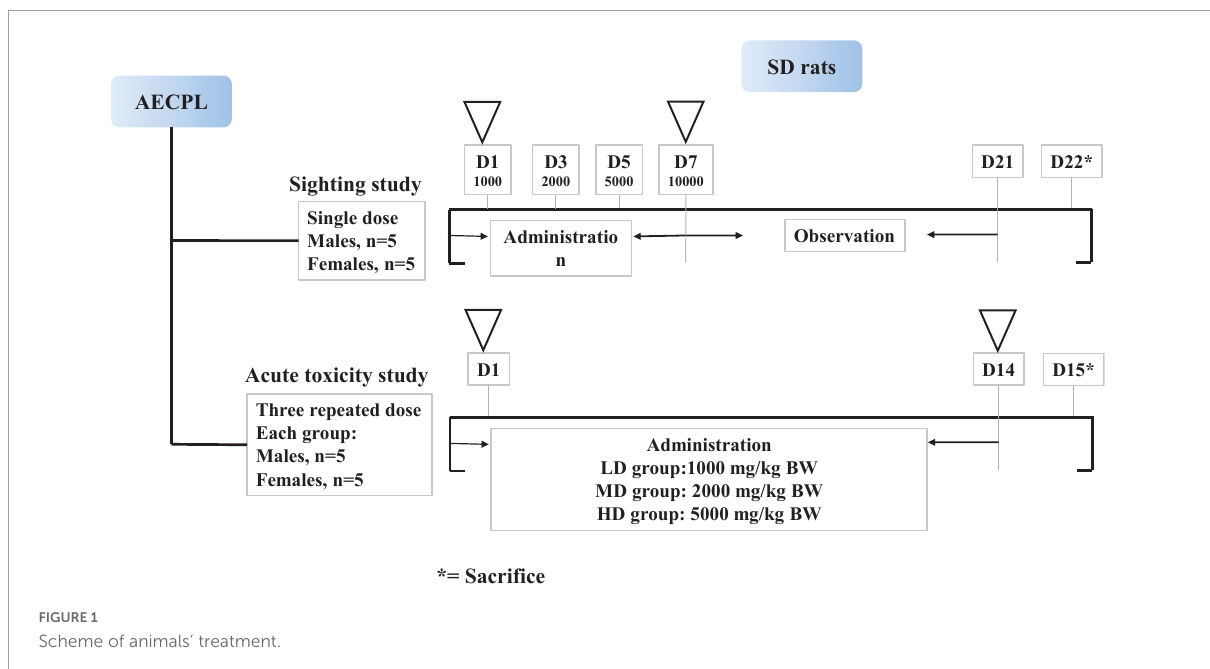
FIGURE1 Scheme of animals’